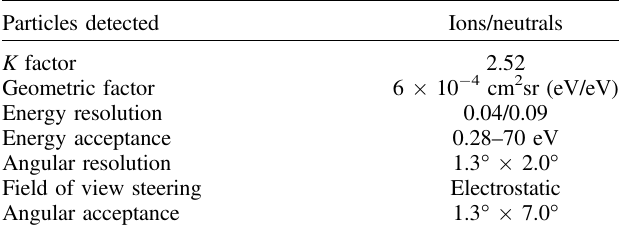
Fig. 6. INMS fl ight model: with the black Ebonol-C coated cylindrical top hat (left), and without (right), showing the fl ight digital boards (courtesy UCL/MSSL). Table 2. Characteristics of